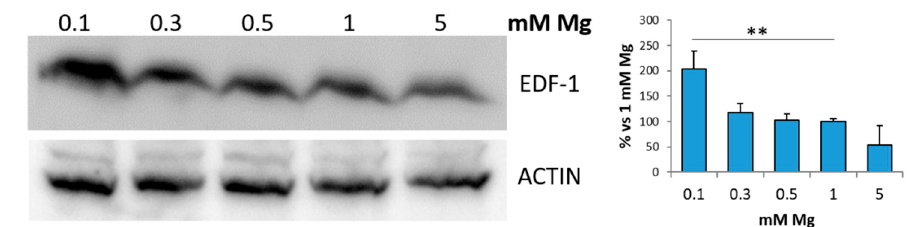
Figure 1. Low magnesium induces EDF-1. HUVEC were cultured in medium containing 0.1, 0.3, 0.5, 1 or 5 mM of extracellular Mg for 24 h. Cell extracts were processed for Western blot using antibodies against EDF-1. Actin was used as a control of loading. A representative blot is shown. Densitometry (right panel) was performed on three different blots using Image J. ** p ≤ 0.01.